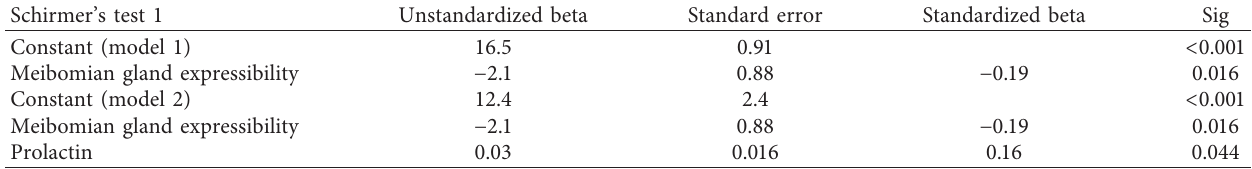
Table 3: Multiple linear regression analysis for predictors of Schirmer’s test